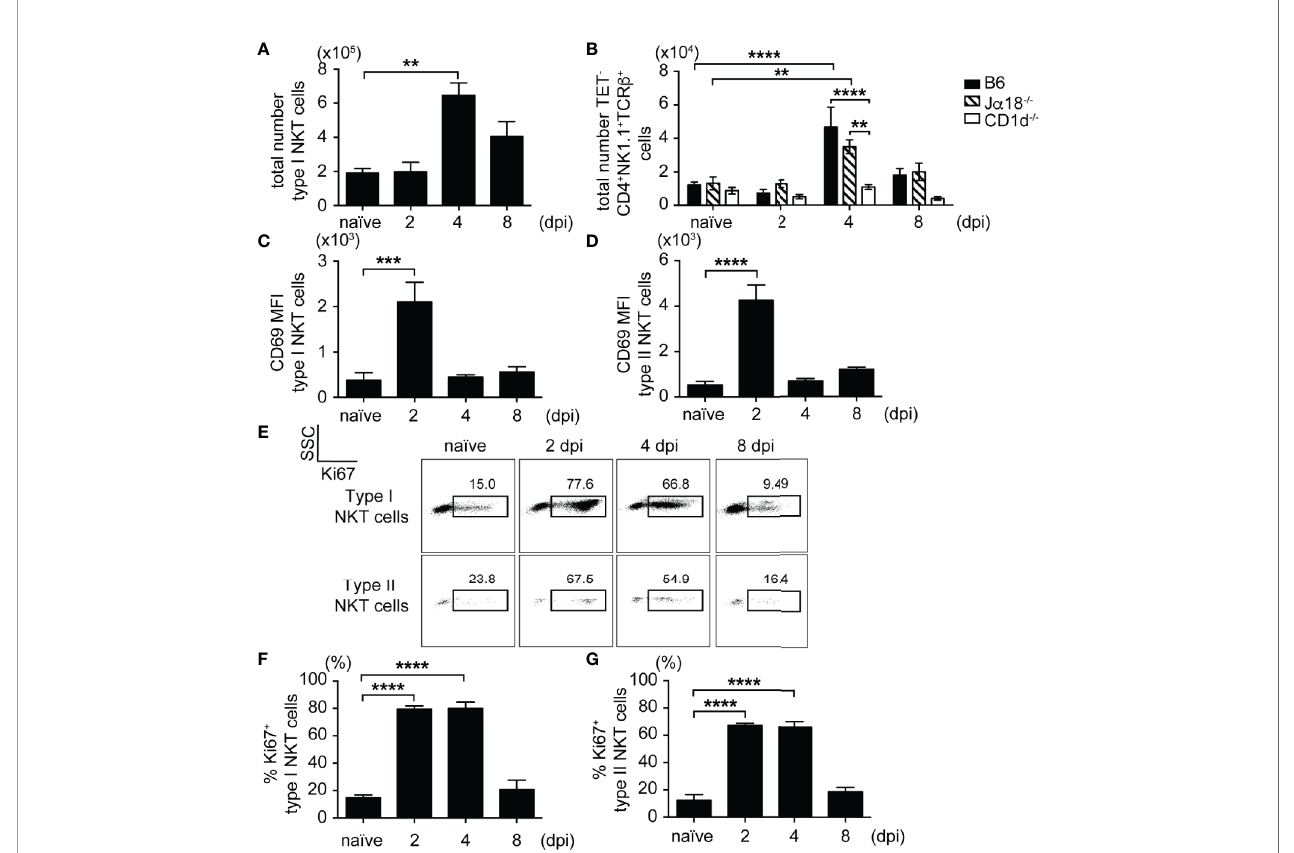
FIGURE 3 | iNKT and type II NKT cells are expanded and activated after SA infection. (A, B) Total number of iNKT and type II NKT cells in liver at various times post infection (N=4 – 5 naïve, N=4 – 8 infected mice/timepoint). (C, D) CD69 mean fl uorescence intensity (MFI) of iNKT cells (C) and type II NKT cells (D) from the liver of SA-infected B6 mice or J a 18 -/- mice, respectively (N=4 naïve, N=4 – 6 infected mice/timepoint). (E – G) Ki67 expression in iNKT and type II NKT cells from SA-infected B6 liver. Representative Ki67 dot plot (E) , quanti fi ed as % of iNKT cells (F) and type II NKT cells (G) (N=4 naïve, N=3 – 7 infected mice/timepoint). Statistical analysis: (A, C – G) one-way ANOVA, (B) 2-way ANOVA. **p < 0.01; ***p < 0.001; ****p <